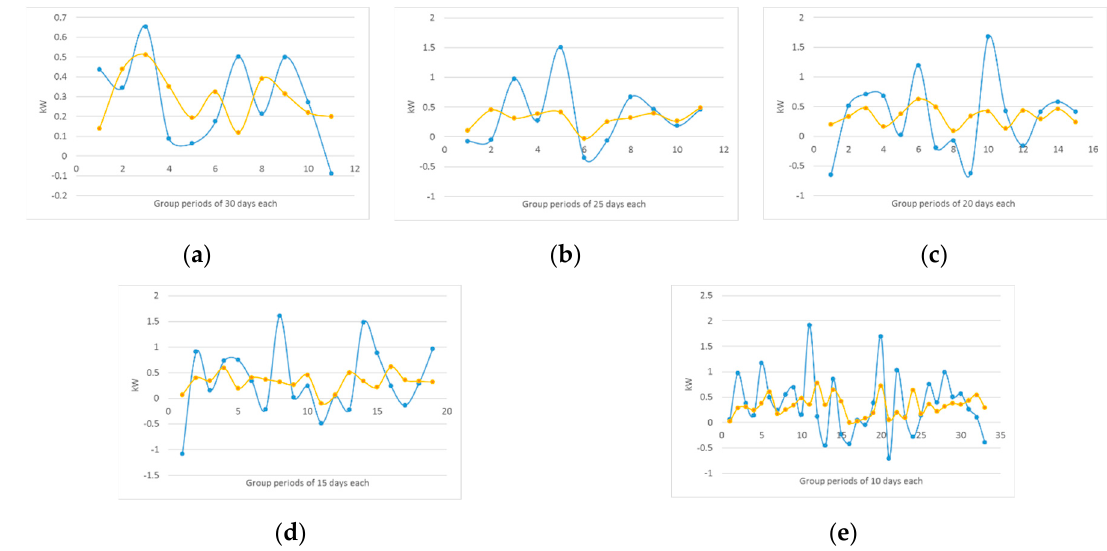
Figure 15. Forecast error E for the estimated wind power for horizons of: ( a ) 30 days ahead; ( b ) 25 days ahead; ( c ) 20 days ahead; ( d ) 15 days ahead; and ( e ) 10 days ahead. The blue and yellow lines correspond to the WS and SF seasons, respectively.